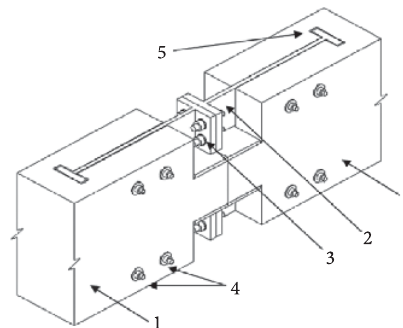
Fig. 2. Beam to beam connection: 1 – timber element; 2 – steel detail; 3 – mounting bolts; 4 – constructive bolts; 5 – contact zone between timber and steel